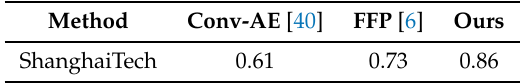
Table 2. AUC comparison on the ShanghaiTech dataset.